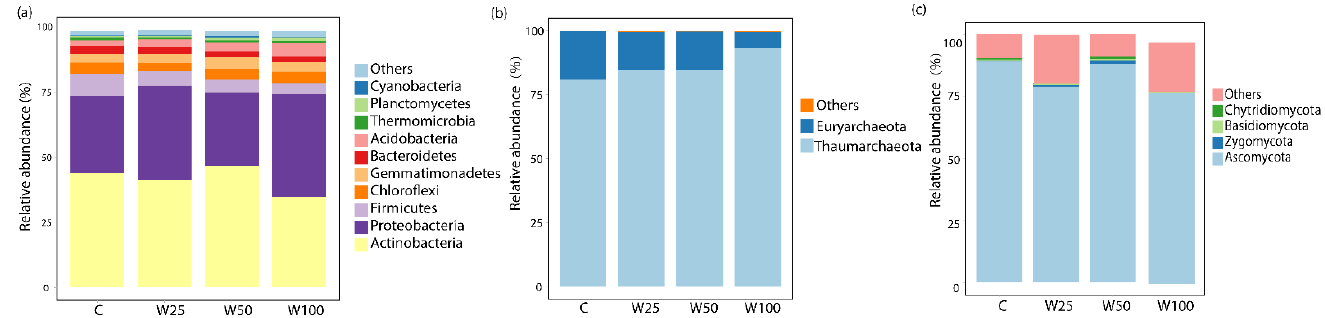
Figure 3. Relative abundances of microbial phyla in bacterial ( a ), archaeal ( b ), and fungal ( c ) communities. C = ambient precipitation; W25 = ambient precipitation +25% of local annual mean precipitation; W50 = ambient precipitation +50% of local annual mean precipitation; W100 = ambient precipitation +100% of local annual mean precipitation.